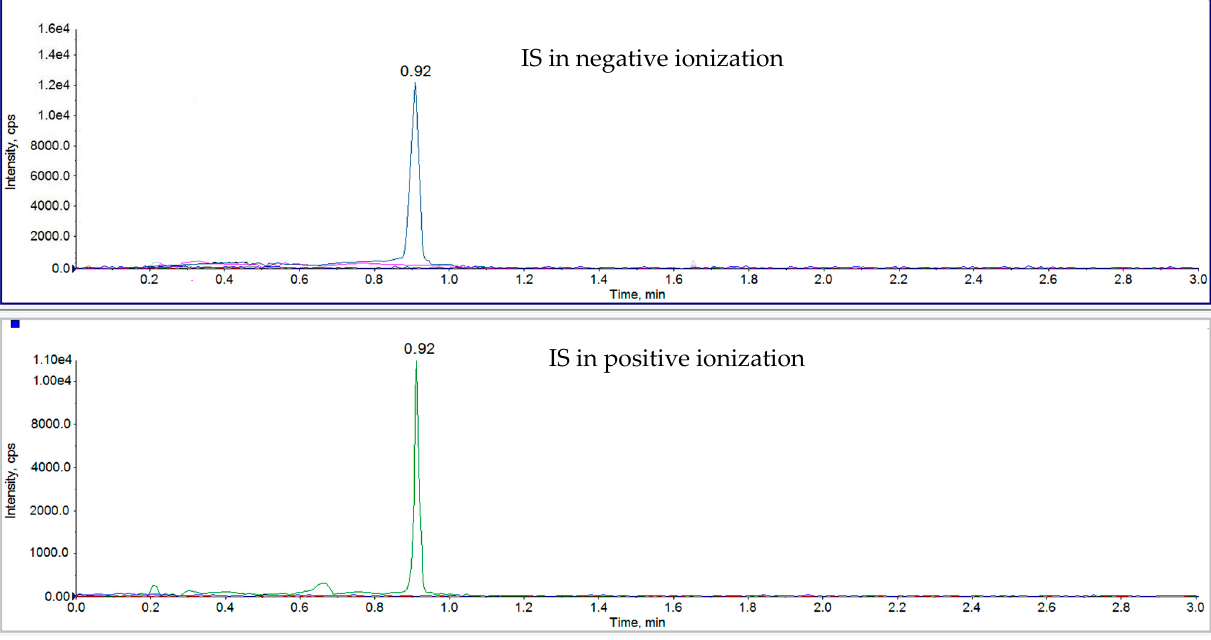
Figure 2. UHPLC-MS/MS XICs, blank muscle sample from geese spiked with 4-Acetamidophenyl β -D-glucuronide-d3 sodium salt (PG-d3) IS at 25 µg/kg in negative and positive ionization, respectively.